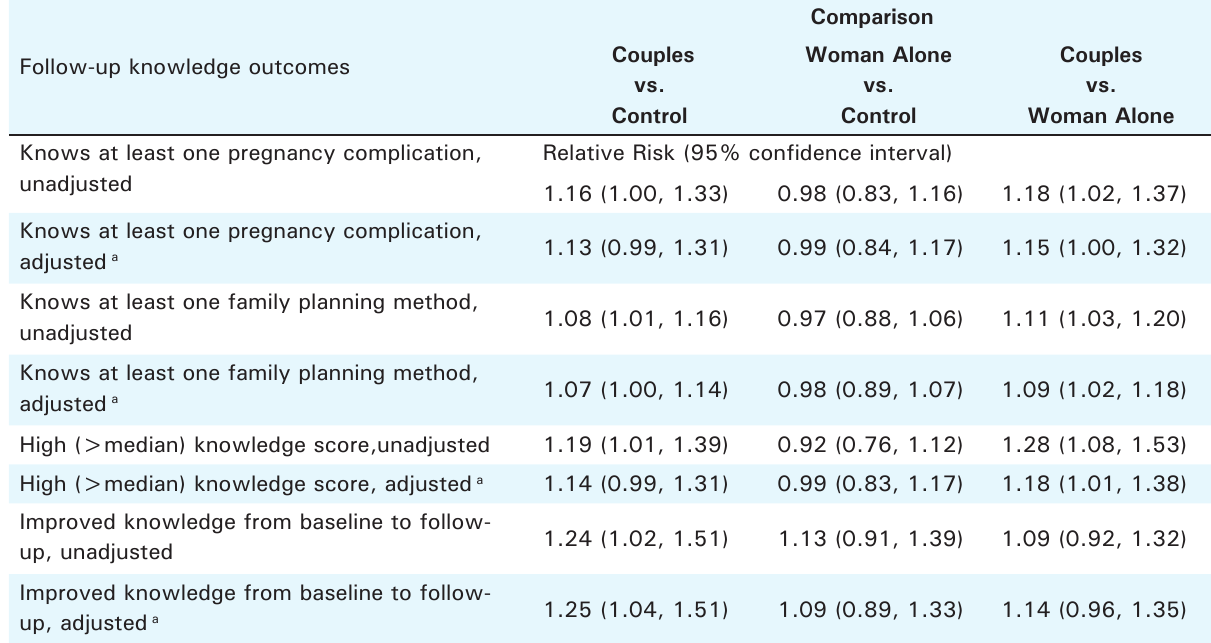
table 3. Relative risk estimates and 95% confidence intervals for maternal health knowledge outcomes, by study group and comparison